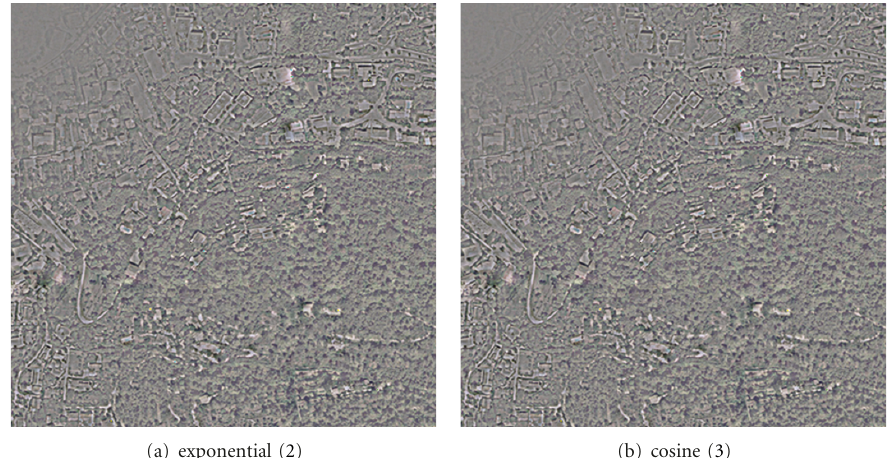
Figure 14: Di ff erence images with the original full-resolution tessellation